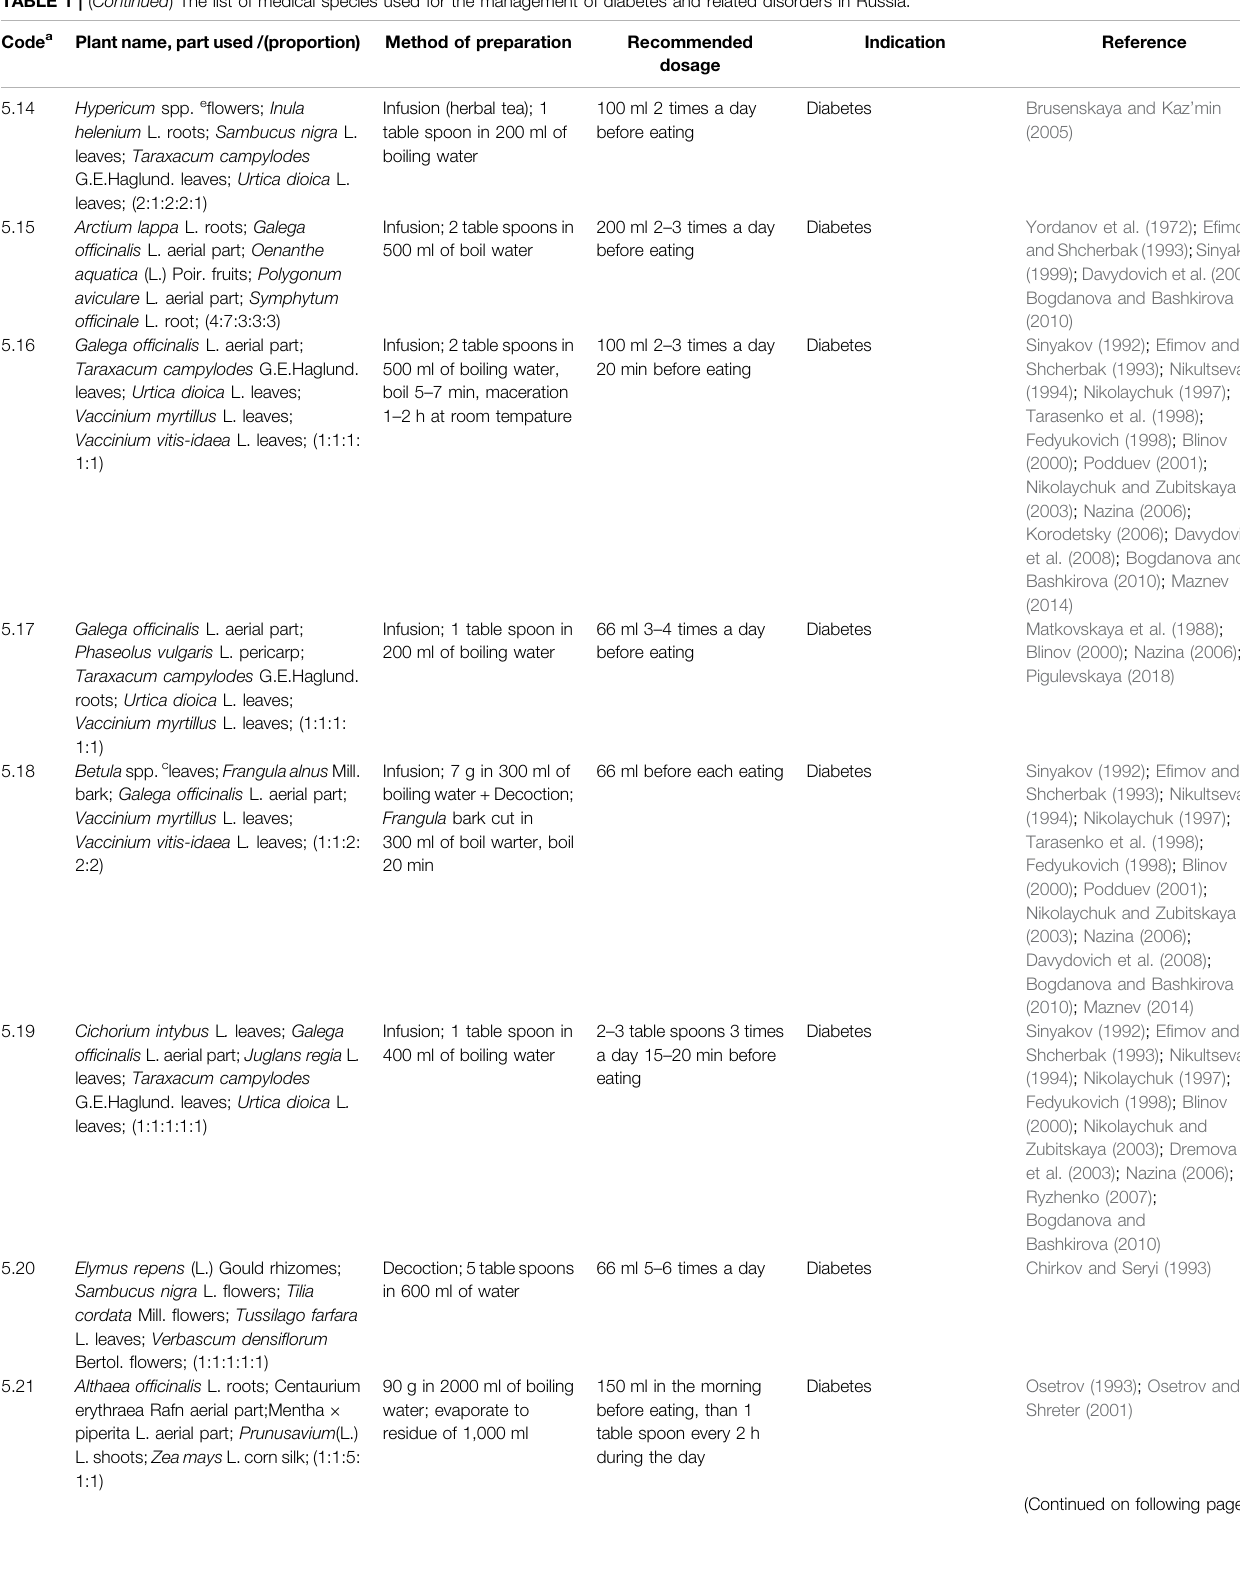
TABLE 1 | ( Continued ) The list of medical species used for the management of diabetes and related disorders in Russia. Code a Plant name, part used /(proportion) Method of